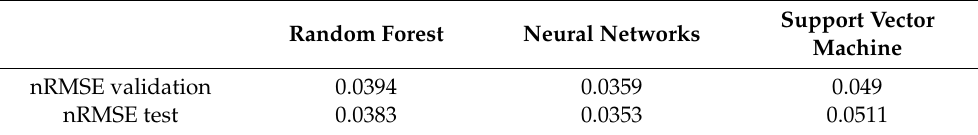
Table 1. Comparison of the random forest, artificial neural network, and support vector machine methods for the prediction of the SO 2 flow rate. The values of the nRMSE on the validation and testing datasets are